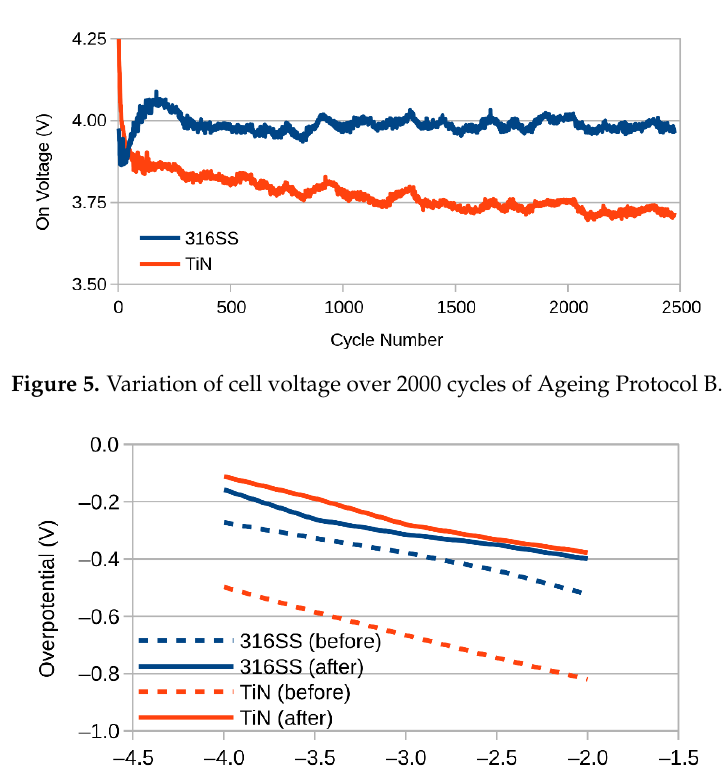
Figure 6. Tafel plots before and after Ageing Protocol B.